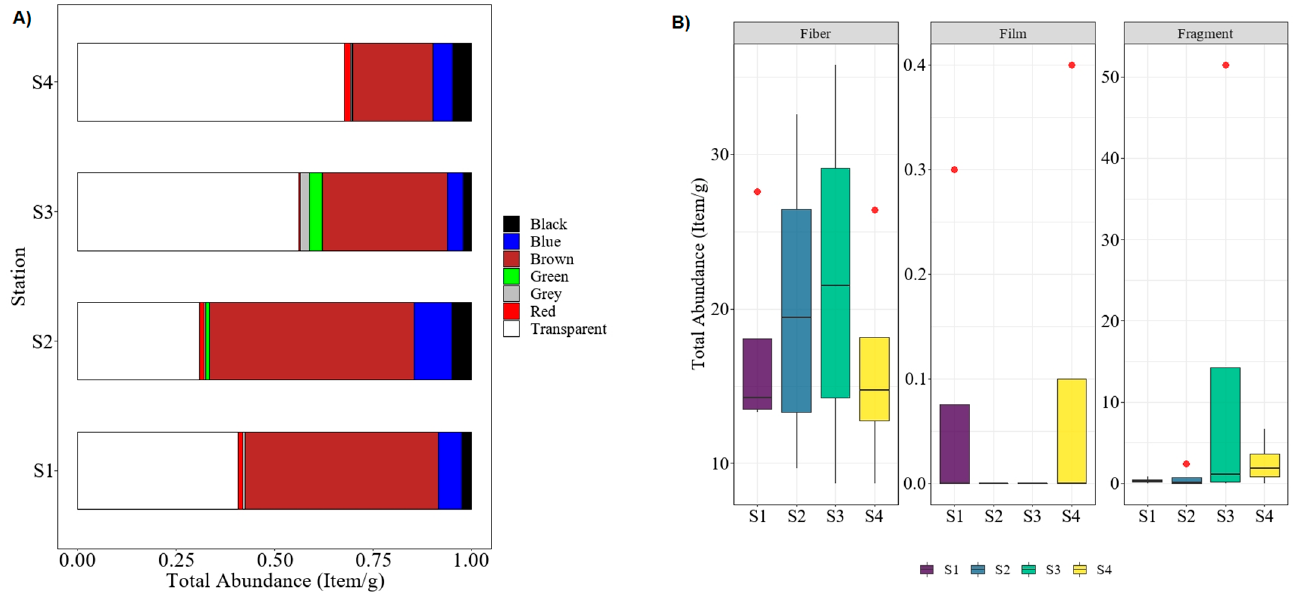
Figure 2. Percentage abundance of microplastic found in polychaete of sampling stations S1–S4: ( A ) based on color, ( B ) based on shape.